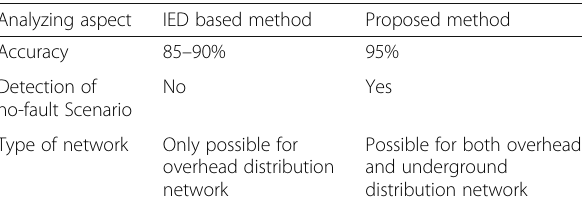
Table 4 Comparison of the proposed method with IED